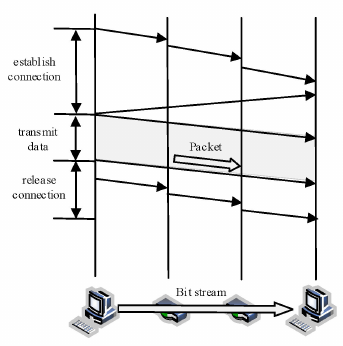
Figure 1. The whole process of circuit